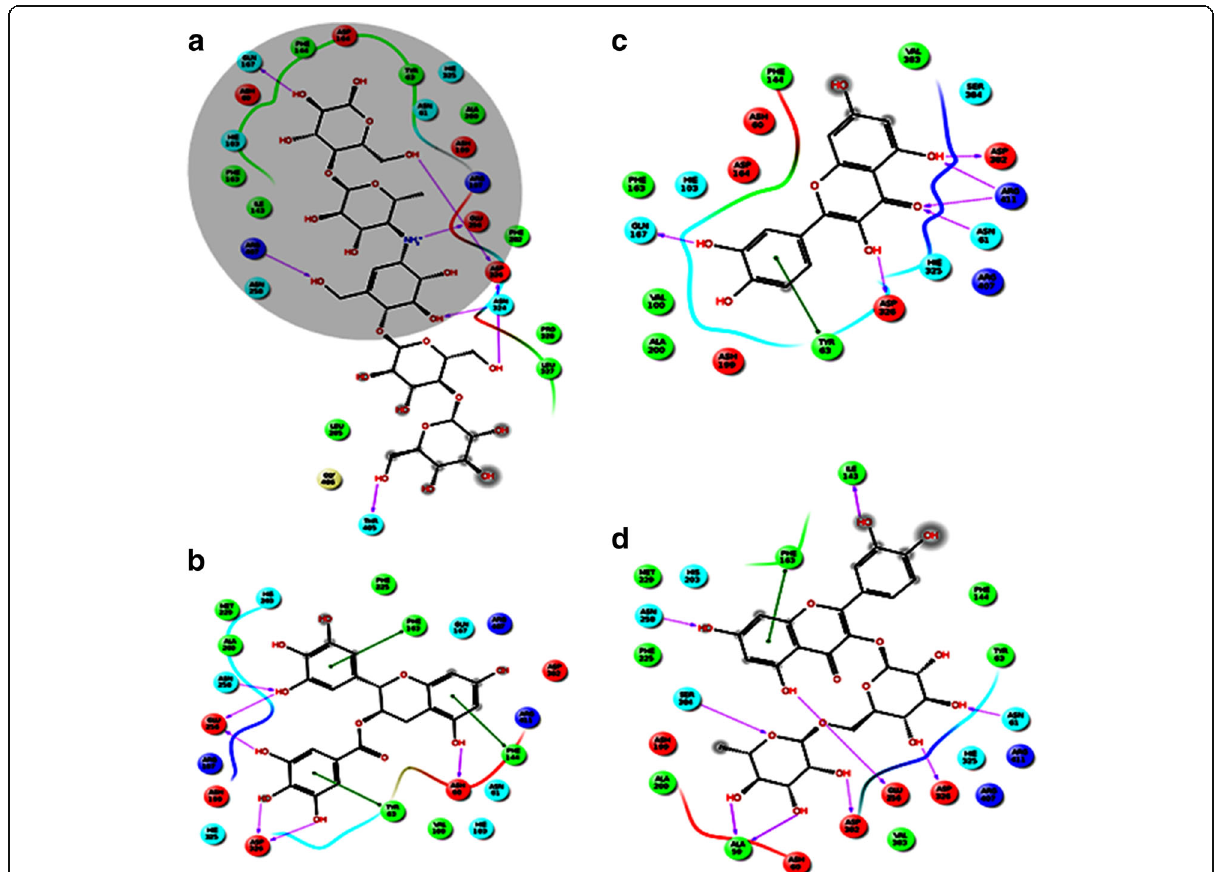
Fig. 8 Mode of binding of different compounds and acarbose in α - glucosidase enzyme active sites. a Acarbose, b Epigallocatechin gallate, c Quercetin and d Rutin. The highlighted area in a is the common area between acarbose and all compounds